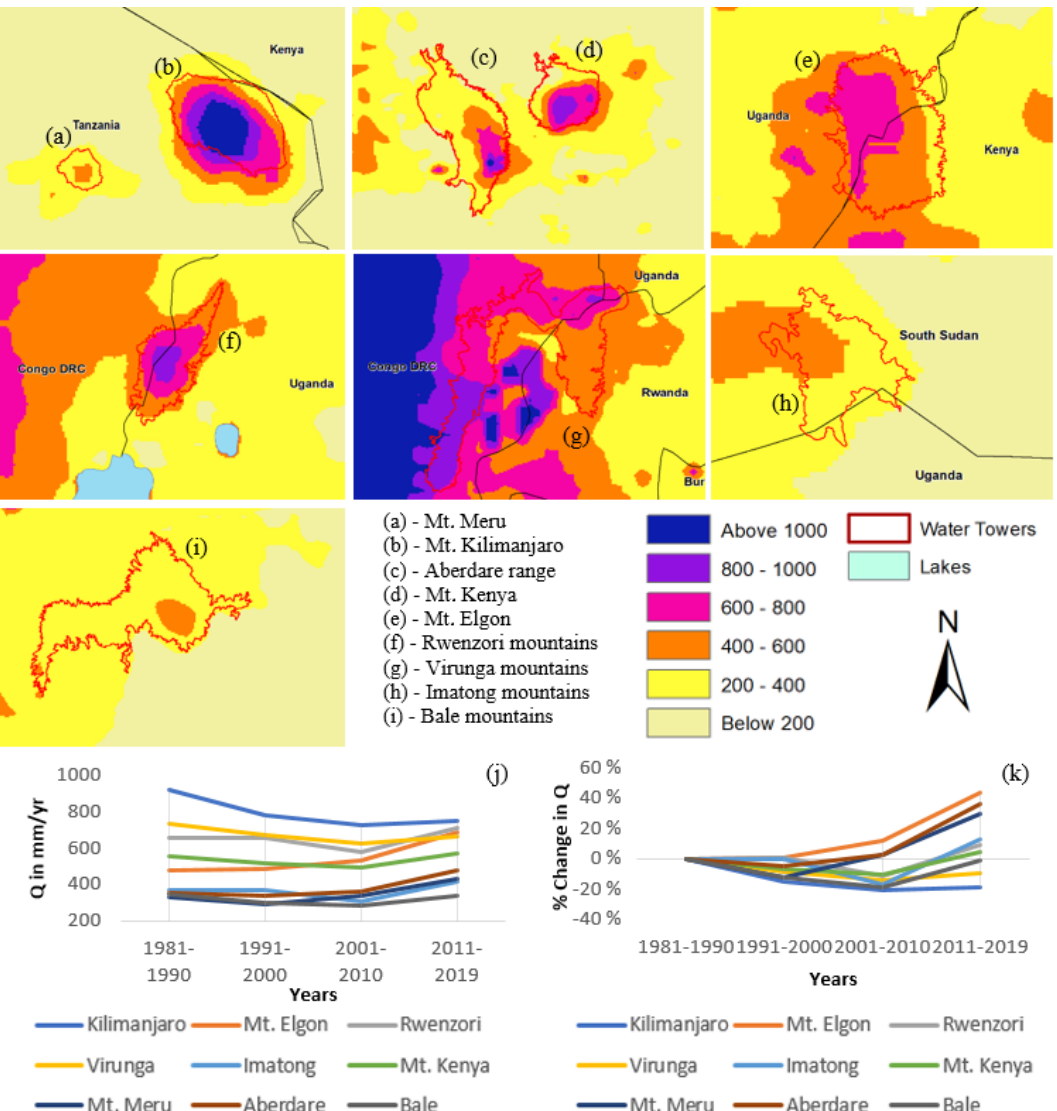
Figure 7. Distribution of long-term water yield ( Q ). The spatial distribution in and around the water towers (a–i) and the changes in the different water towers (j, k) are